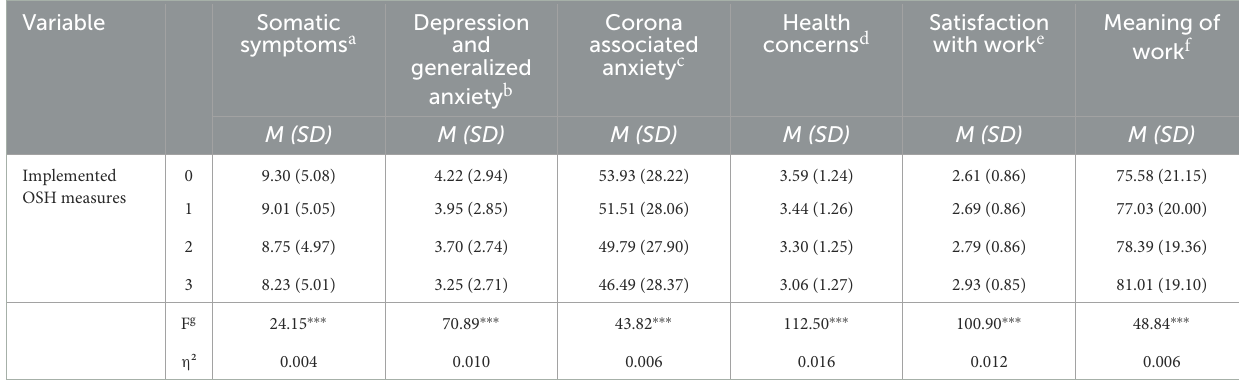
TABLE 2 Health- and work-related associations with OSH measures.